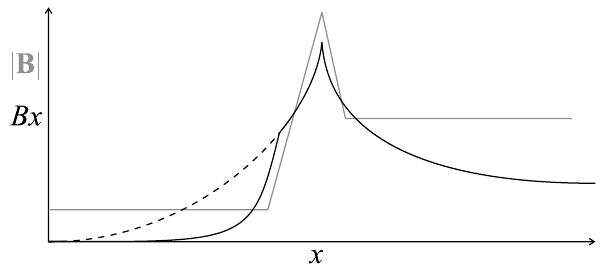
Fig. 9. A sketch of our model for a shock surface wave. The sur- face mode consists of a pair of exponential solutions which meet at the top of the overshoot. At a point upstream of the overshoot, the local flow velocity exceeds the local fast mode wave speed and the surface mode’s exponential solution (dotted line) decays more